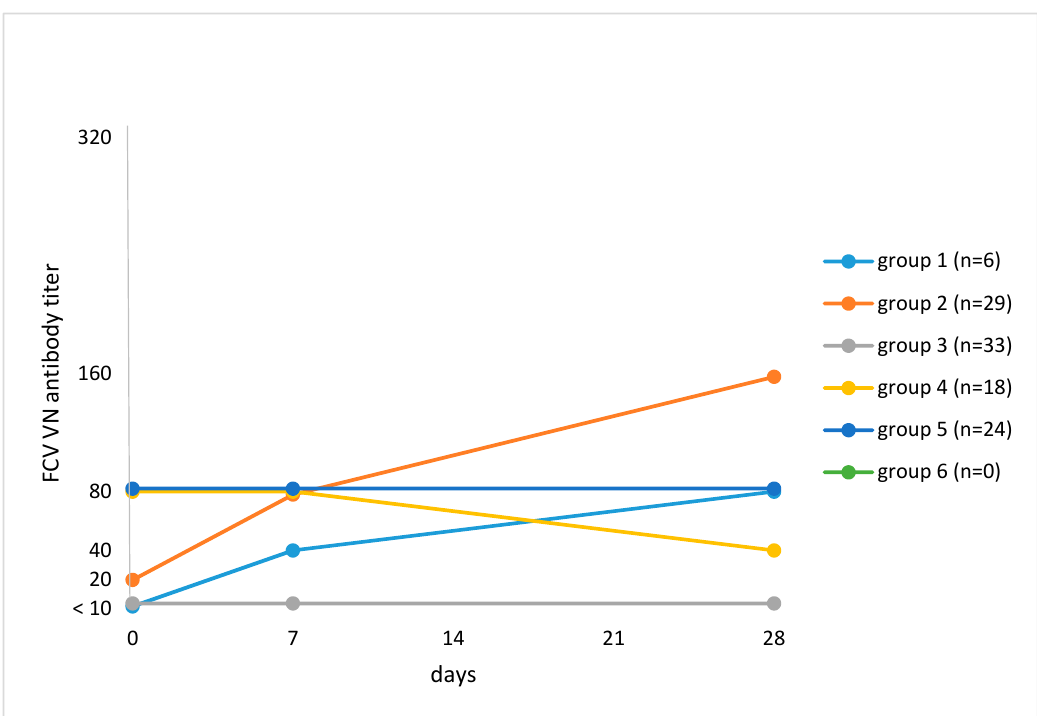
Figure 1. Grouping of cats based on median feline calicivirus (FCV) antibody titers on Day 0 and changes in titer after vaccination against FCV in virus neutralization (VN) testing. The numbers of cats at each time point are given in Section 2.2. Study protocol. Group 1: Titer < 10 on Day 0 and subsequent increase in titer ( n = 6; 5.5%). Median titers: Day 0, < 10; Day 7, 40; Day 28, 80. Group 2: Titer ≥ 10 on Day 0 and subsequent increase in titer ( n = 29; 26.4%). Median titers: Day 0, 20; Day 7, 80; Day 28, 160. Group 3: Titer < 10 pre- and titer < 10 post-vaccination ( n = 33; 30.0%). Group 4: Titer ≥ 10 on Day 0 and subsequent decrease in titer by Day 28 ( n = 18; 16.4%). Median titers: Day 0, 80; Day 7, 80; Day 28, 40. Group 5: Titer ≥ 10 on Day 0 and no change in titer after vaccination ( n = 24; 21.8%). Median titers: Day 0, 80; Day 7, 80; Day 28, 80. Group 6: Titer ≥ 10 on Day 0, an increase in titer by Day 7 and a decrease in titer by Day 28 ( n = 0;